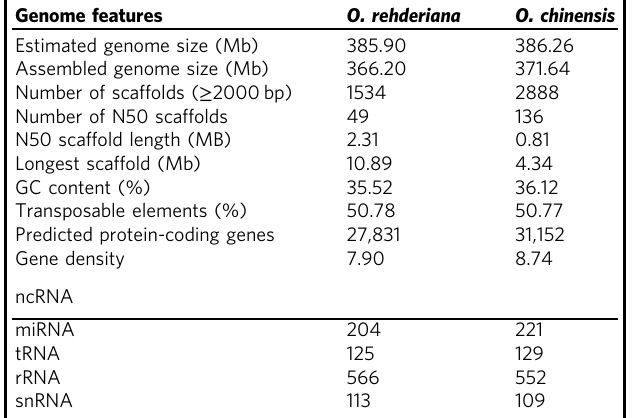
Table 1 Assembly and annotation features of two genomes Genome features